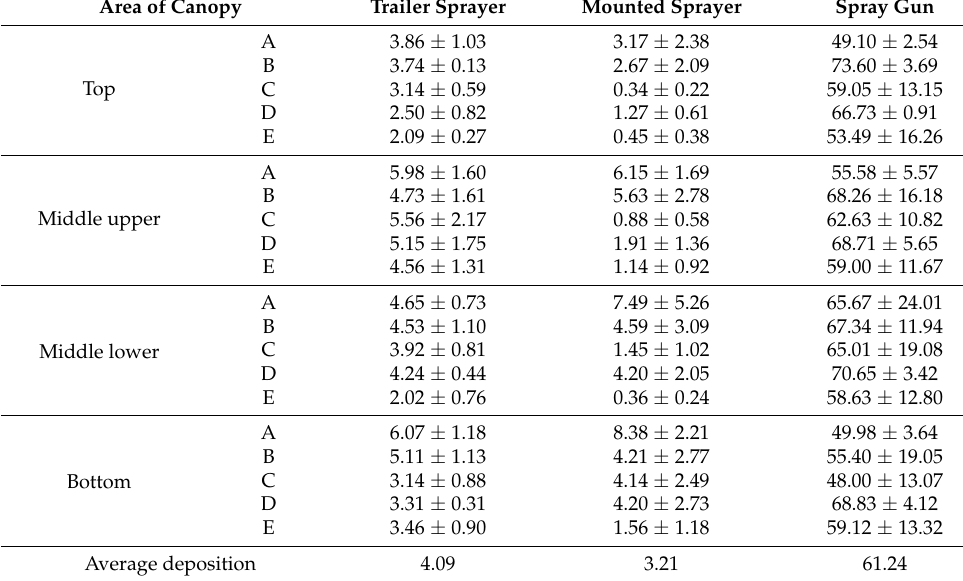
Table 5. Deposition amount ( µ L) and average deposition ( µ L) of spray liquids in the peach canopy. Area of